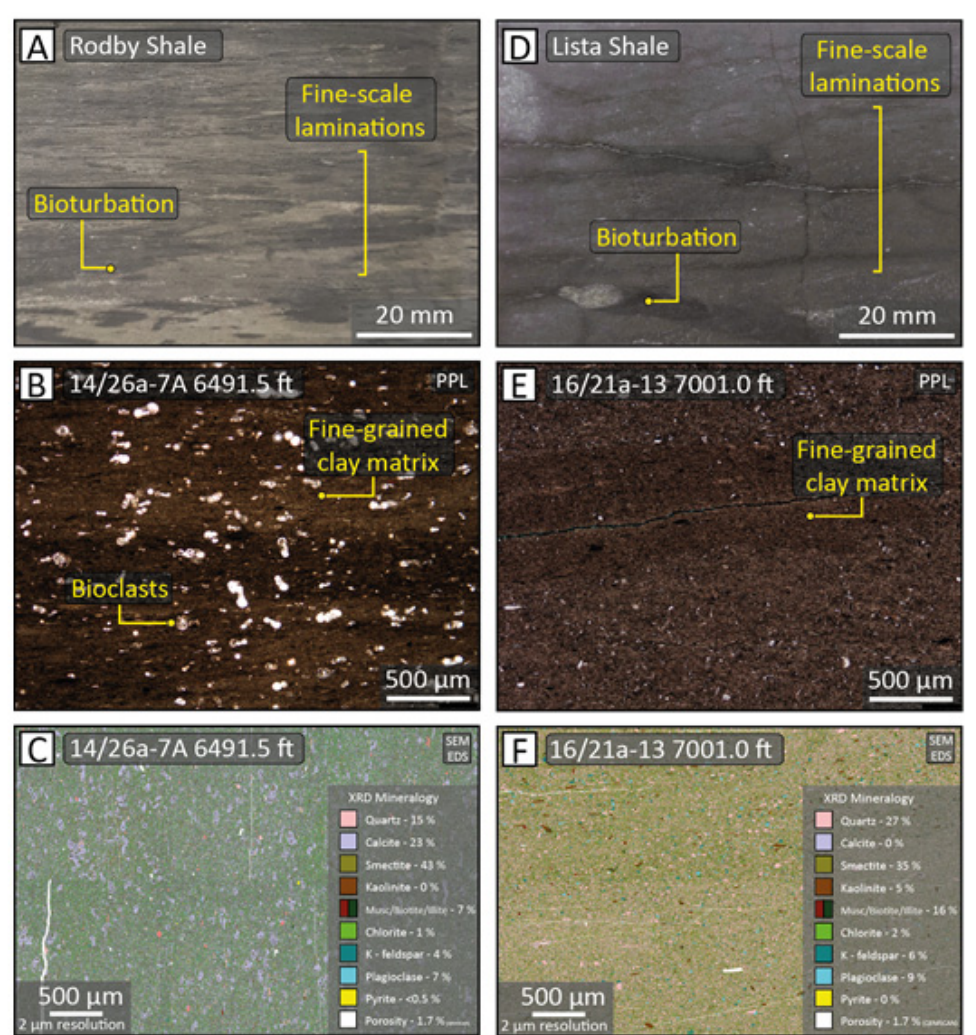
Figure 9. Core, thin section, and high-resolution SEM-EDS images of the Rodby and Lista Shales. ( A ) Fine-scale lamination and bioturbation in the Rodby Shale. The core proved to be highly sensitive to water, suggesting that the rock is rich in smectite. ( B ) Low-resolution light microscope image of the Rodby Shale revealing the dominant fine-grained matrix, silt grains and bioclasts. ( C ) High-resolution SEM-EDS image of a large area of the Rodby Shale, confirming the dominant fine-grained clay-rich (smectite), as well as quartz and calcite silt-sized material. ( D ) Fine-scale lamination and bioturbation in the Lista Shale. The core proved to be highly sensitive to water, suggesting that the rock is rich in smectite. ( E ) Low-resolution light microscope image of the Lista Shale revealing the dominant fine-grained matrix, with very small quantities of silt grains and bioclasts. ( F ) High-resolution SEM-EDS image of a large area of the Lista Shale confirming the dominant fine-grained clay-rich (smectite), with very small quantities of quartz and calcite silt-sized